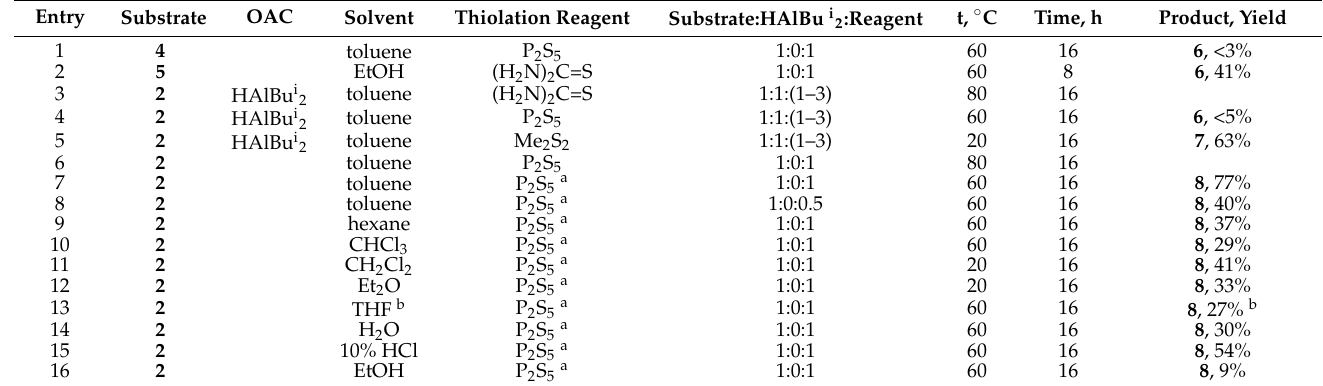
Table 1. Conditions for the synthesis of S-functionalized derivatives of dimer